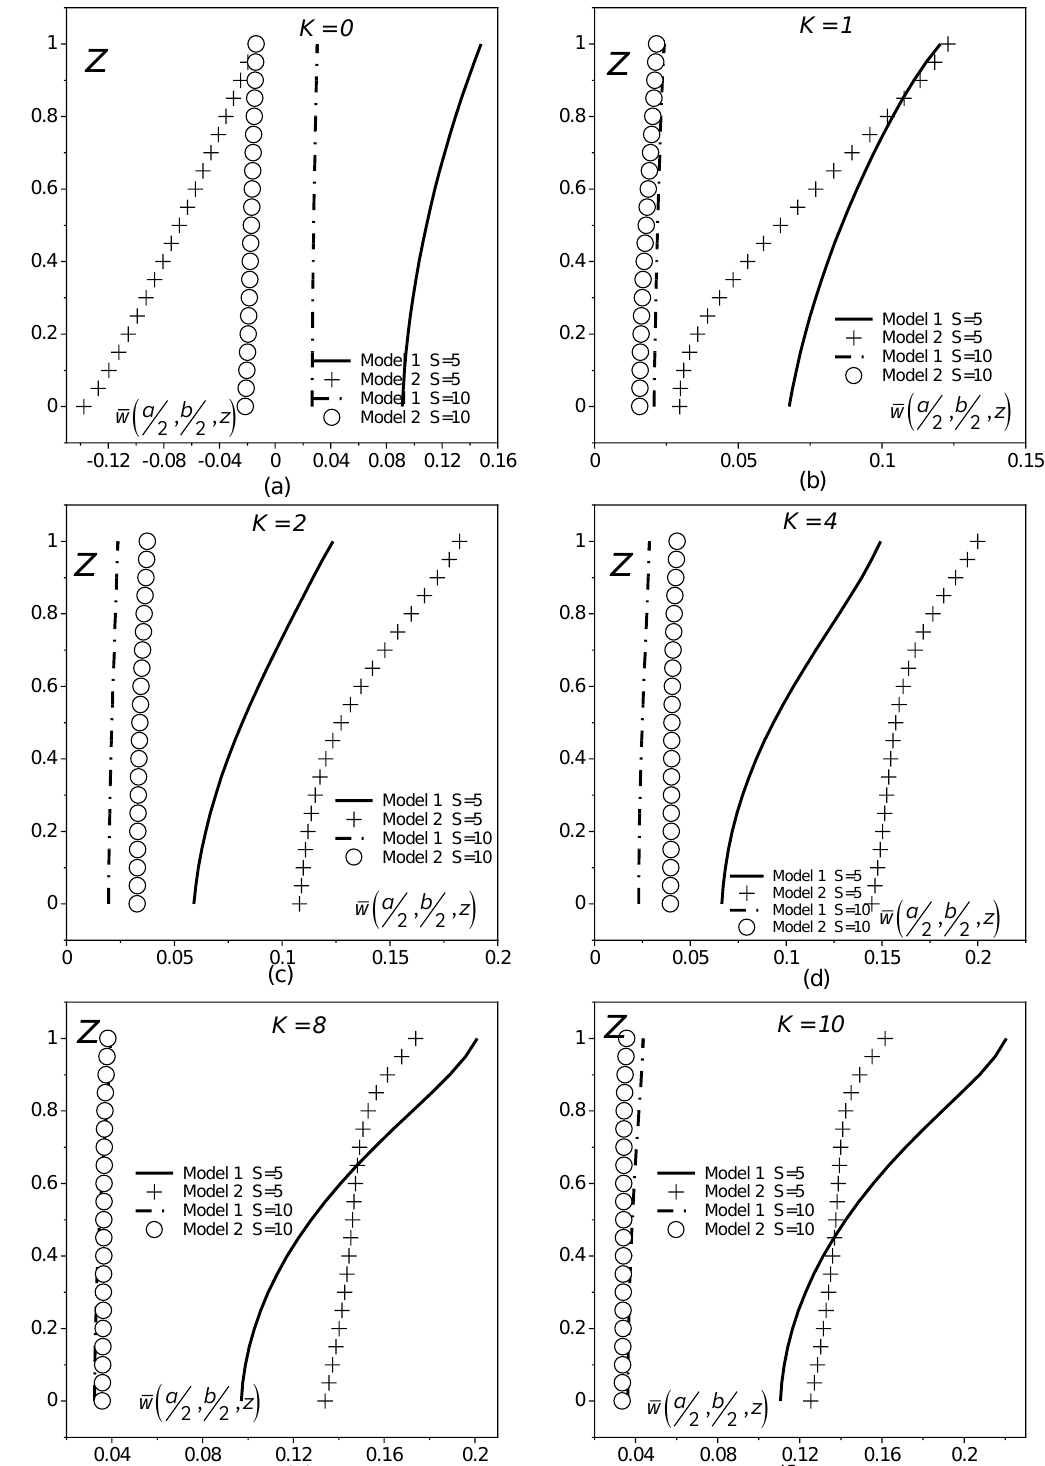
Fig. 7. Thickness variation of normalized Transverse displacement ( w ) for different material graded FG square laminate for material set